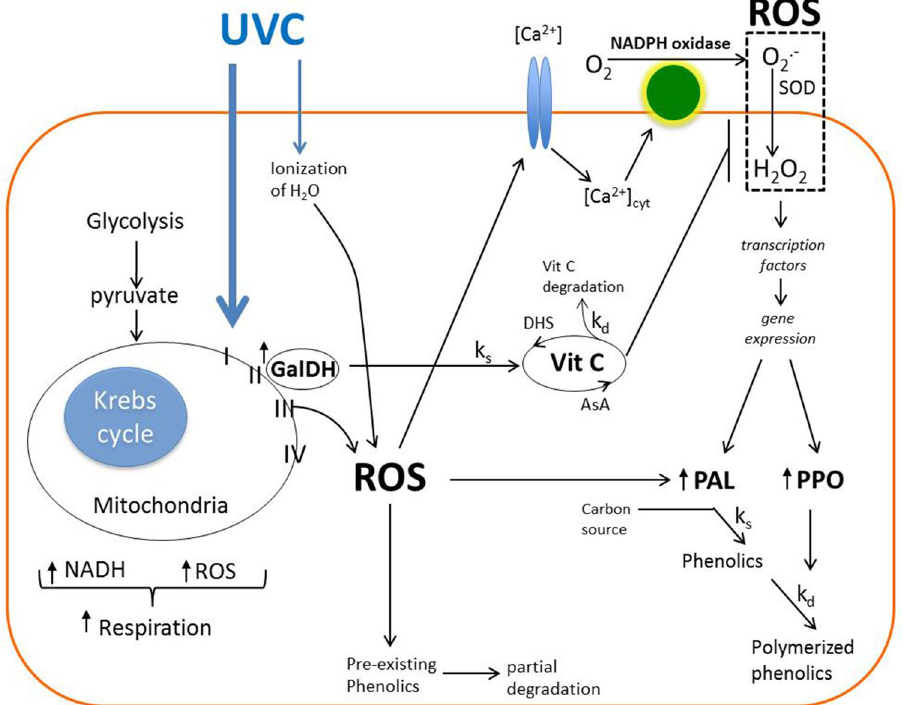
Figure 7. Mechanistic model of UVC stress signaling pathways in acerola. At the immediate UVC response, an initial burst of ROS occurs mediated mainly by a mitochondrial energy dissipating system and secondly a partial ionization of water. The latter mechanism may contribute to the overall pool of ROS generated, while the former mechanism generates an increase in the glycolysis and mitochondria activity (dehydrogenase activity) generating high levels of NADH and ROS. Simultaneously, GalDH is activated promoting the synthesis of ascorbic acid